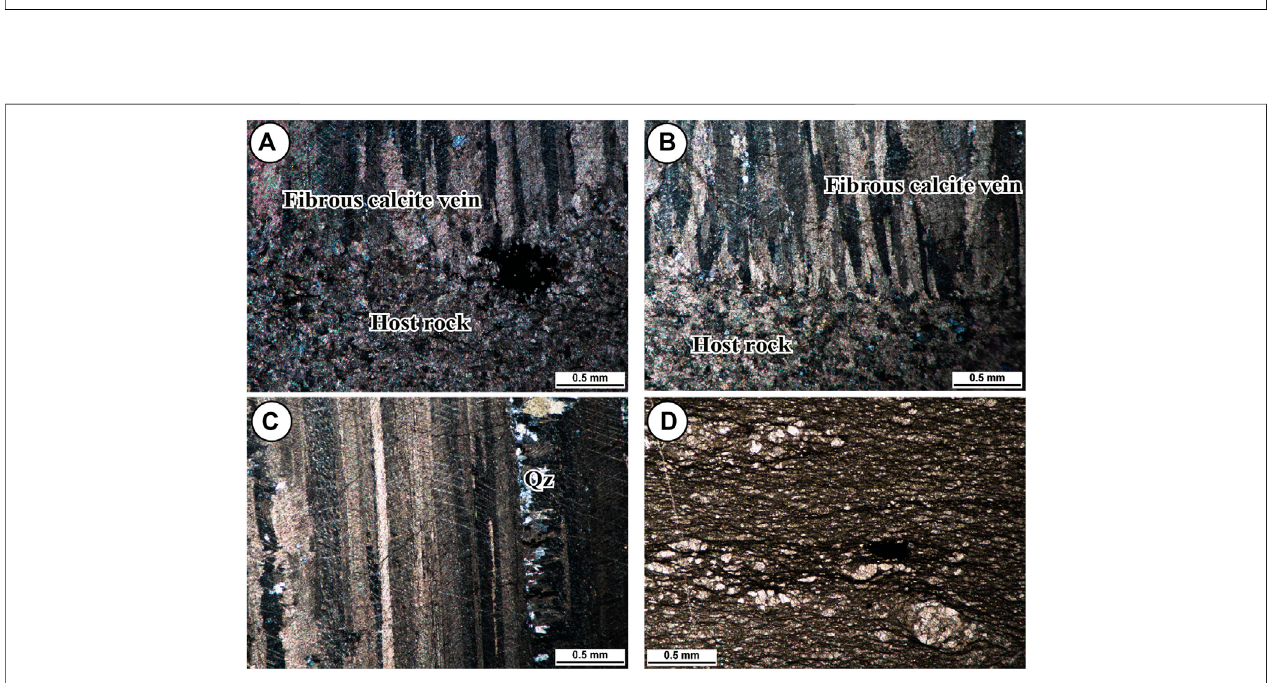
FIGURE 4 | Photomicrographs of the Nam Duk Formation. (A) Beef veins typify the Nam Duk samples; (B) a change from the host rock to beef vein with a median suture line; (C) calcite twining in beef vein associated with quartz crystals; (D) sand grains fl oating in the host rock matrix.